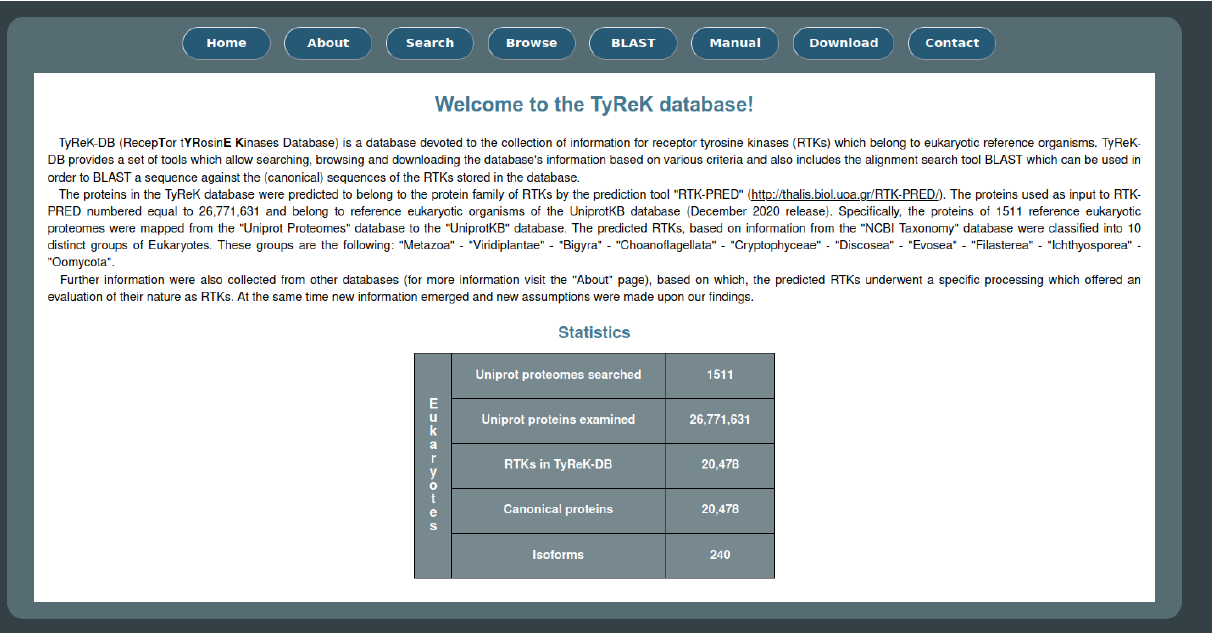
Figure 4. The main interface of the homepage of the TyReK-DB website.4. Discussion.